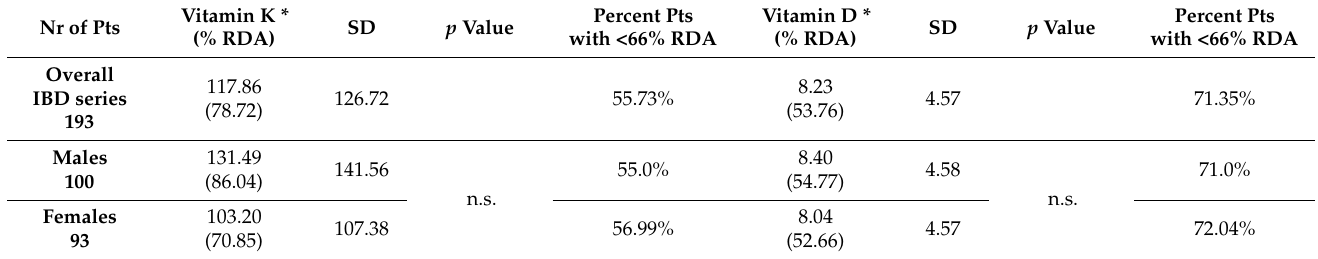
Table 3. Vitamin K and Vitamin D intake in IBD patients in relation to gender, age, disease activity and